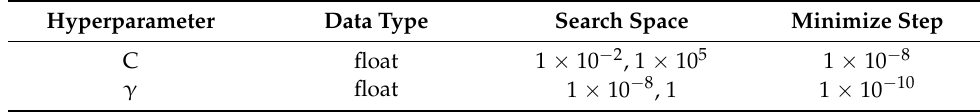
Table 2. Hyperparameters to tune and search